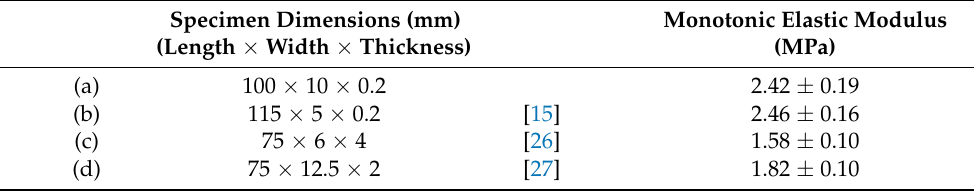
Table 2. Comparison of monotonic elastic modulus with other